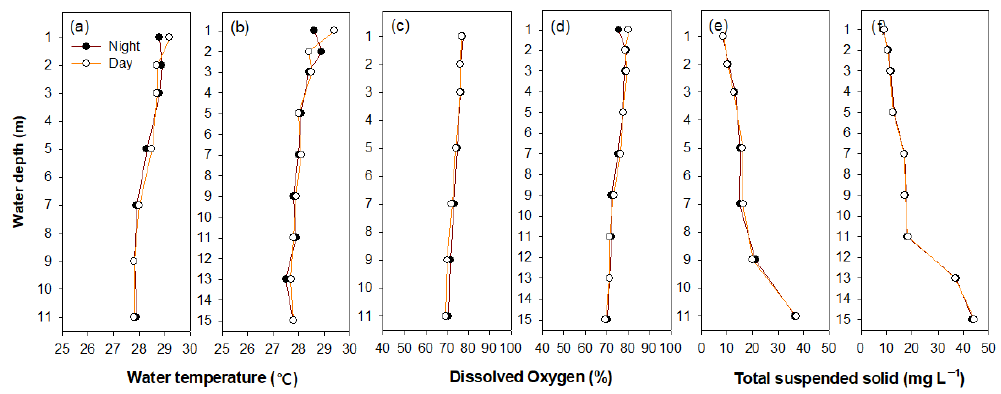
Figure 3. The vertical distributions (at intervals of 1–2 m) of water temperature ( a , b ), dissolved oxygen